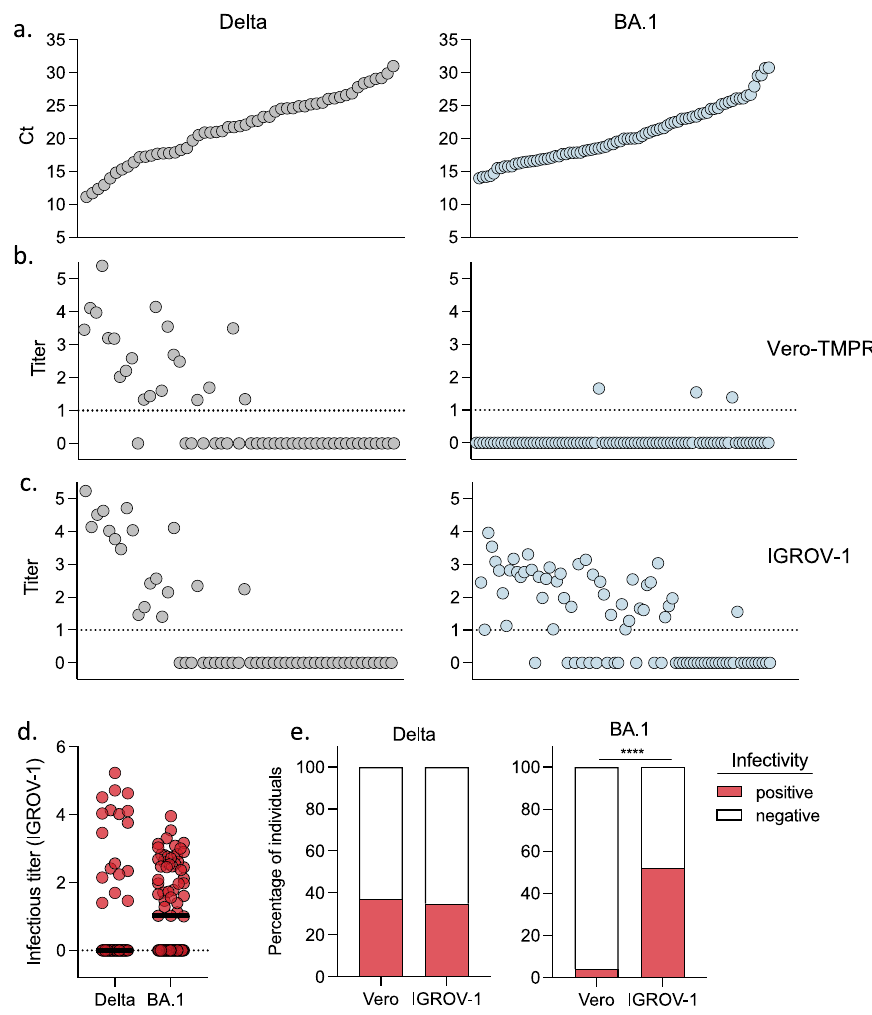
BA.1-positive samples are depicted in the left and right panels, respectively. d Comparison of infectious titers for Delta and BA.1 samples in IGROV-1 cells (left panel). e Percentage of samples harboring detectable infectious Delta (middle panel) or BA.1 virus (right panel) using Vero and IGROV-1 cells. A two-sided Chi- square test was performed **** p <0.0001. Source data are provided as a Source Data fi